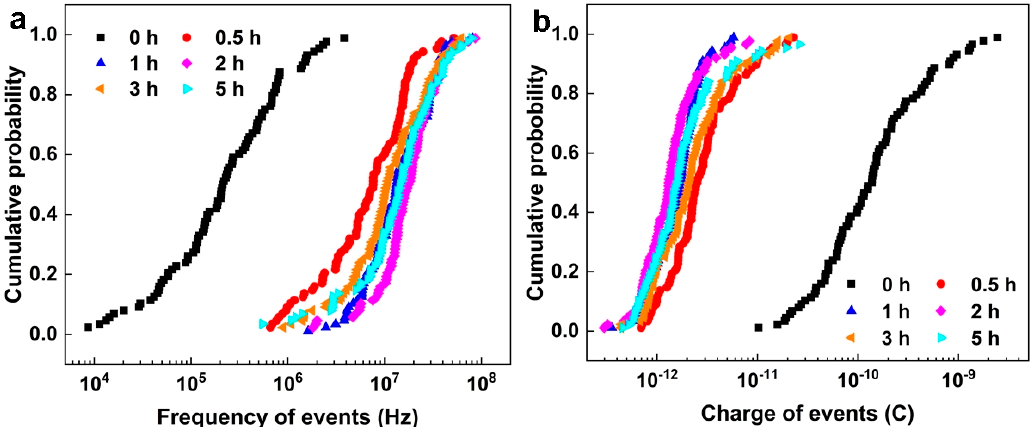
Figure 8. Cumulative distribution of f n ( a ) and q ( b ) of NAB after different CE times.